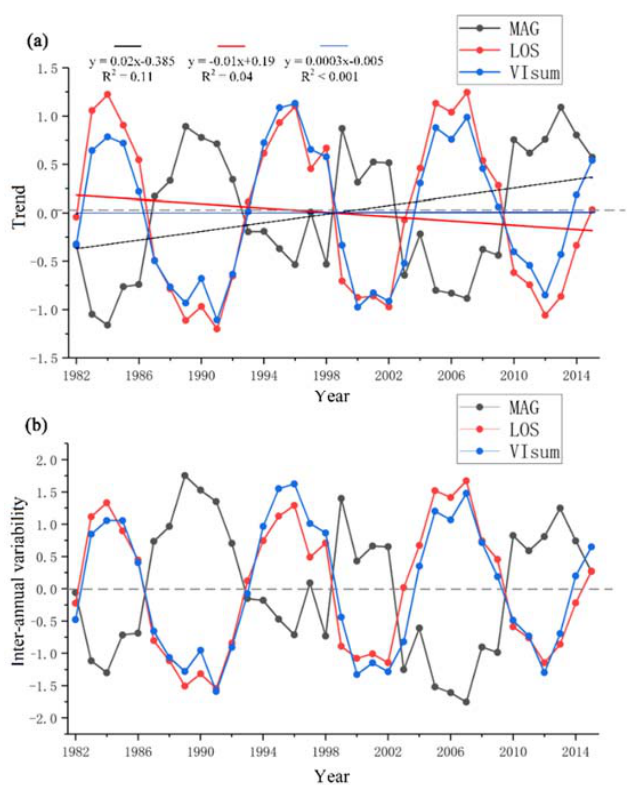
Figure 3. Long ‐ term trends ( a ) and inter ‐ annual variability ( b ) of VIsum , LOS, and MAG for the entire Figure 3. Long-term trends ( a ) and inter-annual variability ( b ) of VIsum,LOS, and MAG for the entire Northeast China (straight lines represent linear regression trends). Northeast China (straight lines represent linear regression